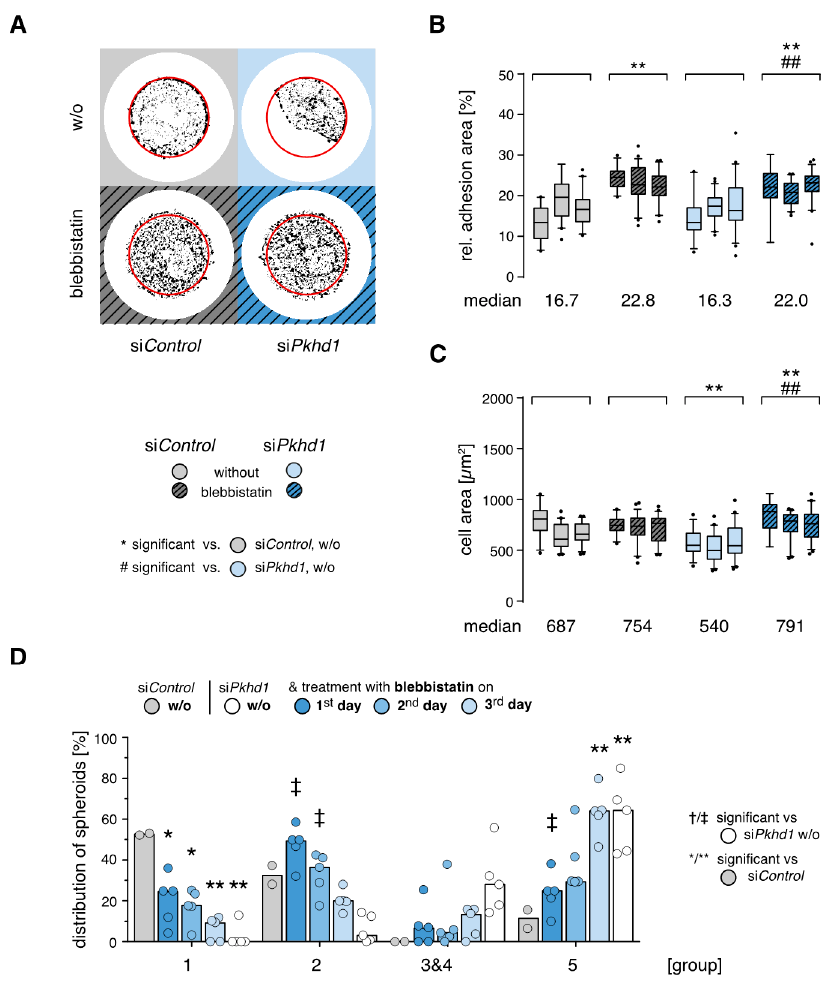
Figure 4. Inhibition of actomyosin contractility reduces cell adhesion and restores spheroid formation of FPC-deficient cells. ( A ) Representative cell shape and adhesion sites of siRNA-treated cells. Three hours after seeding onto 700 µm 2 , cells were treated with myosin II inhibitor, blebbistatin (40 µM), for 1 h. ( B , C ) Relative adhesion area and cell spreading of si Pkhd1 and si Control cells on 700 µm 2 treated with blebbistatin and controls ( n = 3 independent experiments, >120 cells per condition; two-way ANOVA/Tukey’s, p < 0.01, ** or ##.) ( D ) Spheroid formation by siRNA-treated cells was modulated by treatment with blebbistatin for 24 h at different time points after seeding. Inhibition of cell contractility is most effective during the 1st day of spheroid formation, leading to restoration of correct epithelial polarity (groups 1 and 2). ( n = 2–5 independent experiments, median bars; >140 spheroids per condition; two-way ANOVA/Tukey’s, p < 0.05/0.01, */** or †/‡).